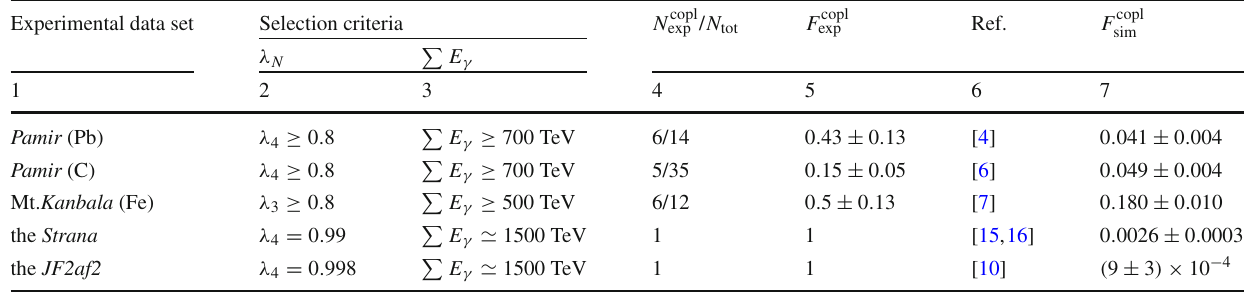
Table 1 Summary of experimental data. Columns: 1, Data set and type of used XRECs; 2–3, Criteria for selection of coplanar events; 4, Num- ber of coplanar families, N copl exp , and total family number N tot ; 5,